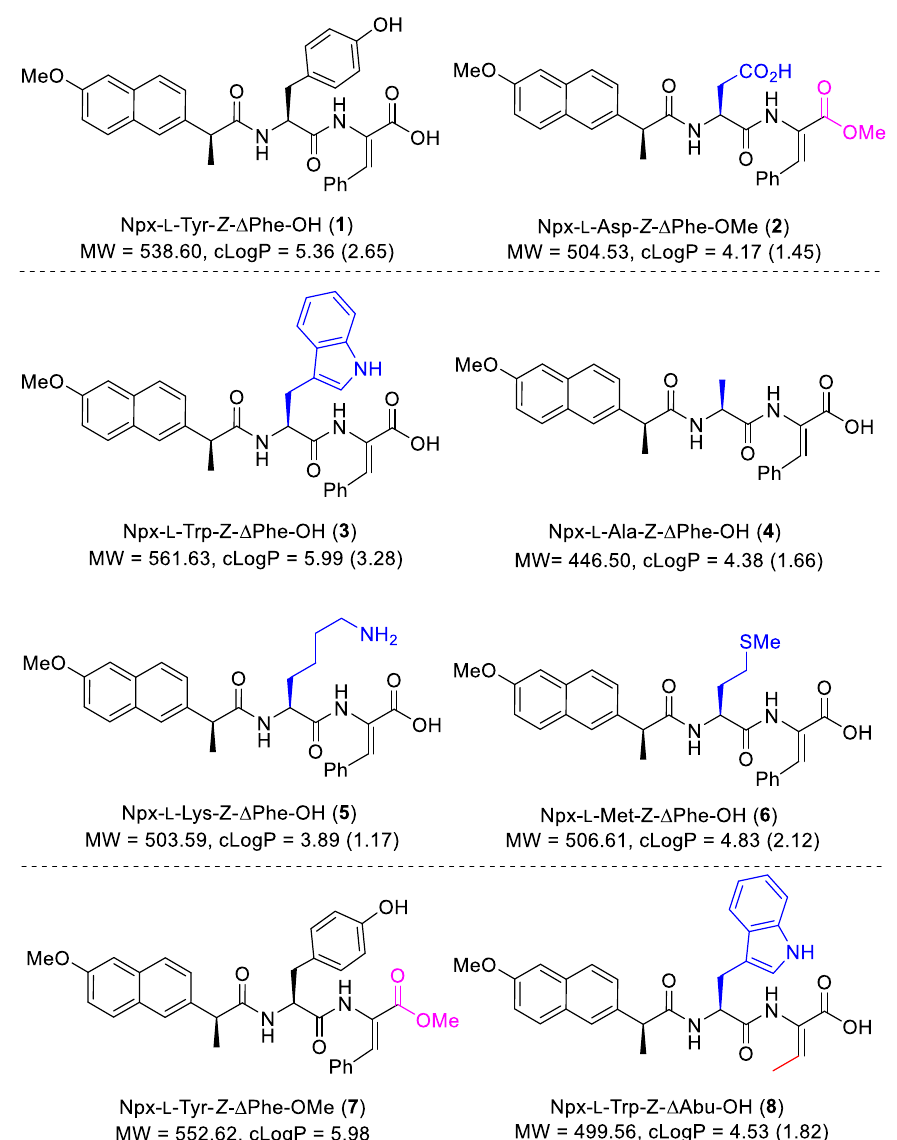
Figure 2. Library of compounds 1 – 8, evaluated for anti-inflammatory and anti-cancer activity. The molecular weight and cLogP data are shown (values in parenthesis refer to the carboxylate salt form).